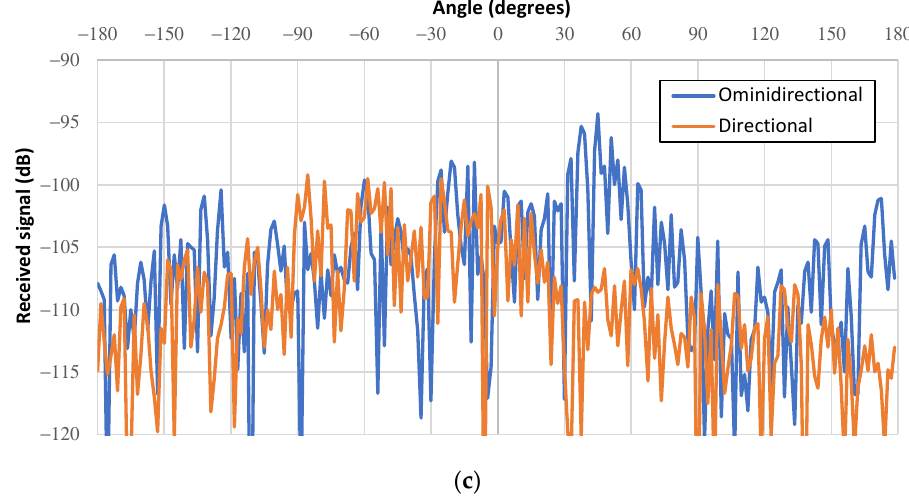
Figure 13. Received signal after deconvolution for different distances from the transmitter: ( a ) 50 m; ( b ) 80 m, ( c ) 100 m.